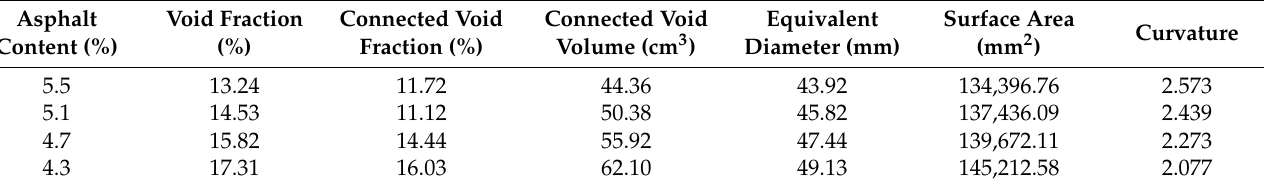
Table 12. Characteristic parameters of the connected void in EPA-13 using CT scanning.